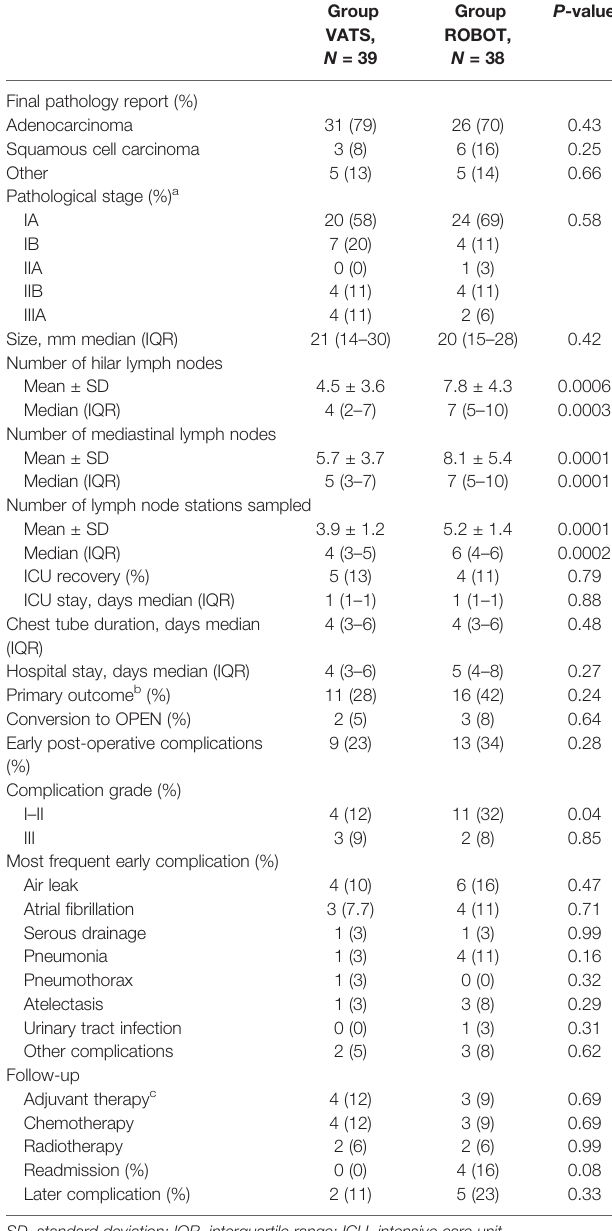
Group VATS, Group ROBOT, N = 39 N = 38